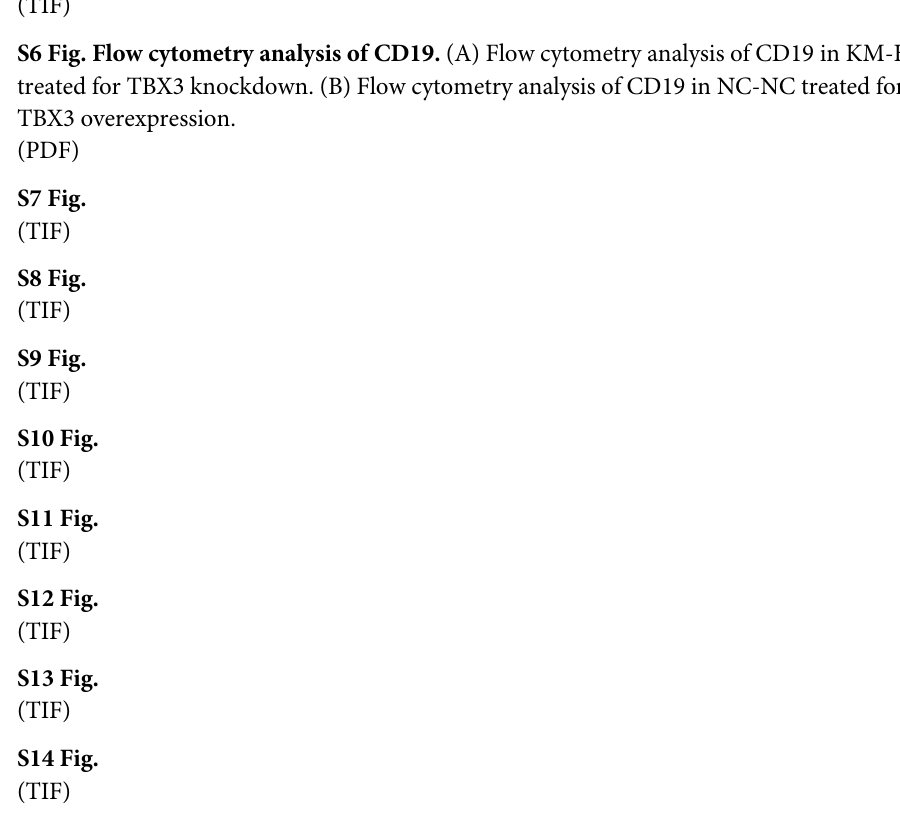
S5 Fig. Life-cell-imaging analyses of KM-H2 treated for E2F4 knockdown. Live-cell-imag- ing of KM-H2 cells treated for siRNA-mediated knockdown of E2F4 showed that E2F4 pro- moted proliferation (left, p = 0.035) and inhibited apoptosis (right, p = 0.001). (TIF) S6 Fig. Flow cytometry analysis of CD19. (A) Flow cytometry analysis of CD19 in KM-H2 treated for TBX3 knockdown. (B) Flow cytometry analysis of CD19 in NC-NC treated for TBX3 overexpression.